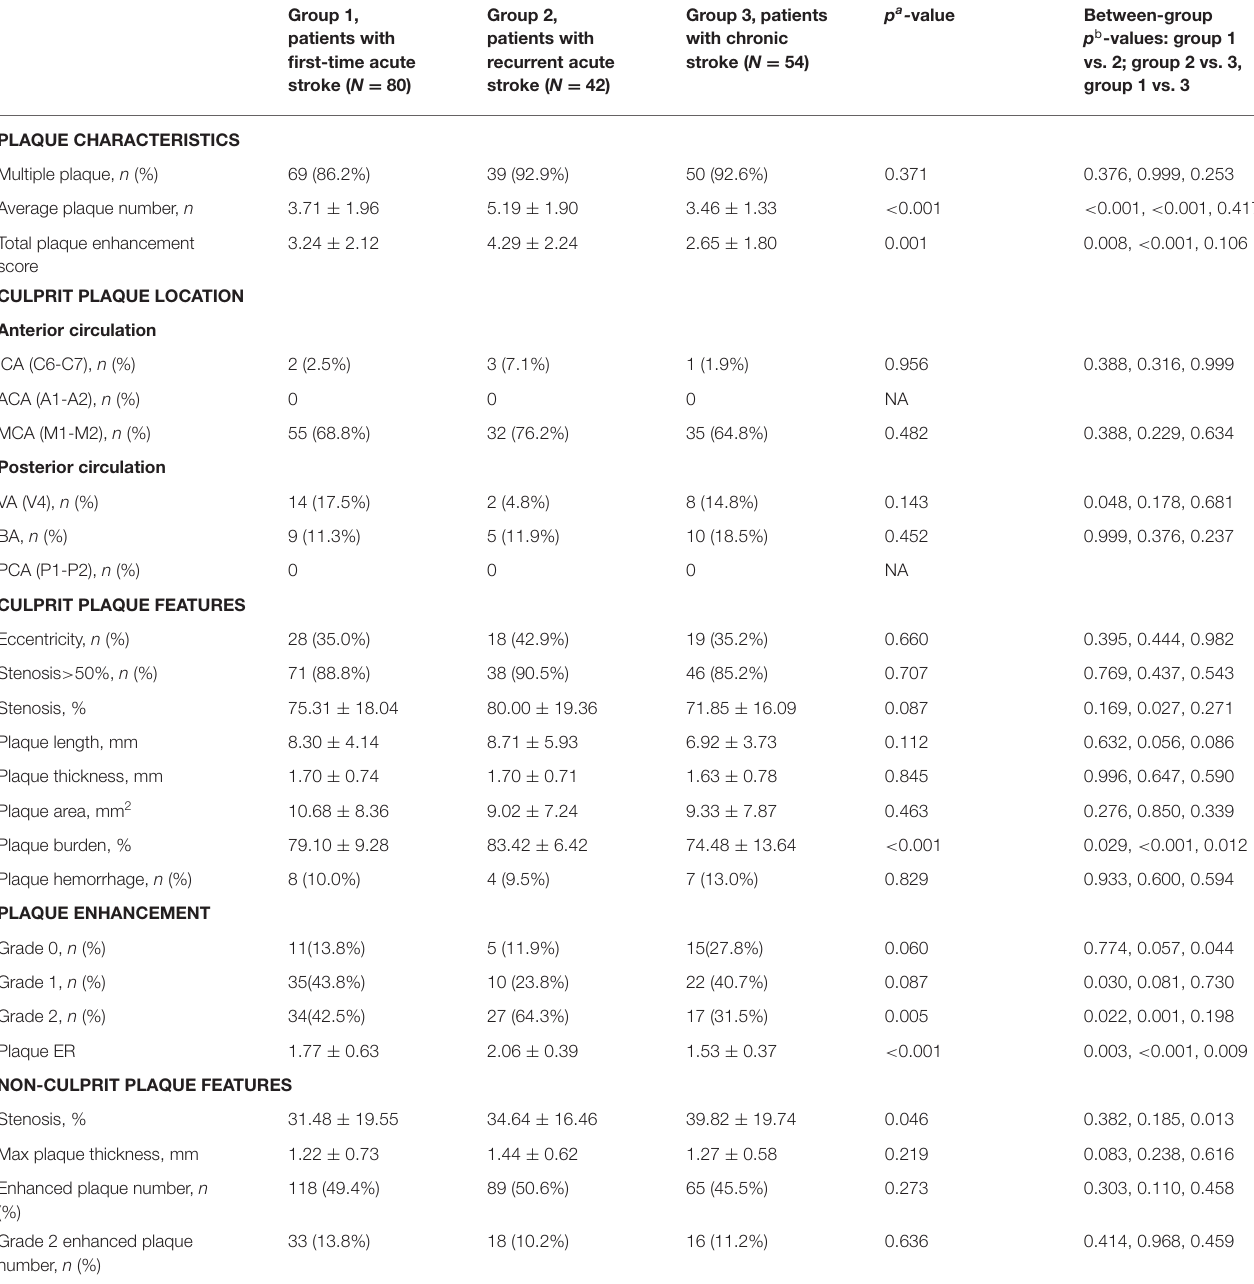
TABLE 2 | Comparisons of plaque features among the three group patients.